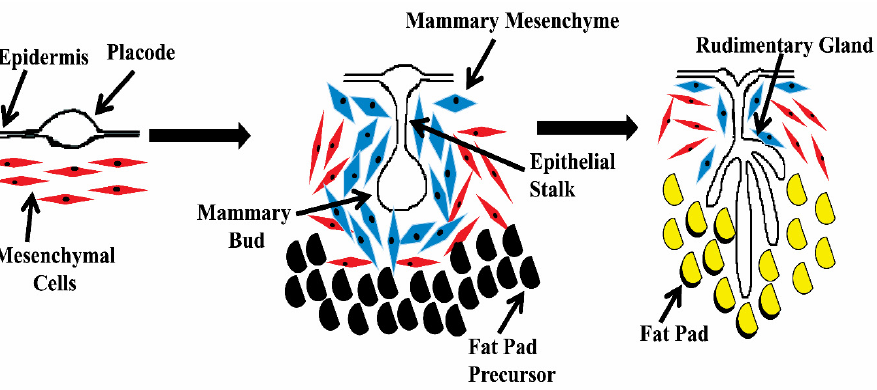
Figure 3. Schematic diagram illustrating the embryonic development of the bovine mammary gland. The mammary placode expands into the mesenchyme and the rudimentary structure sur- rounded by the fat pad [35].